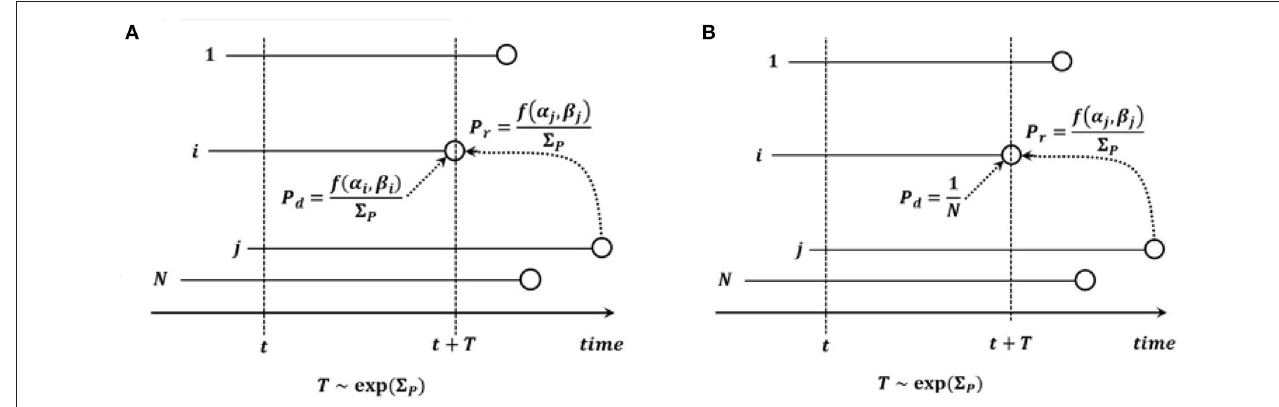
FIGURE 2 | Graphical depiction of (A) Model A and (B) Model B. Notation: N , count of cells in the process; i , cell dying and to be replaced; j , cell replacing cell i ; t , current time; T , time to death - replacement event; f ( α , β ), fitness of cell with α drivers and β passengers; 6 P =